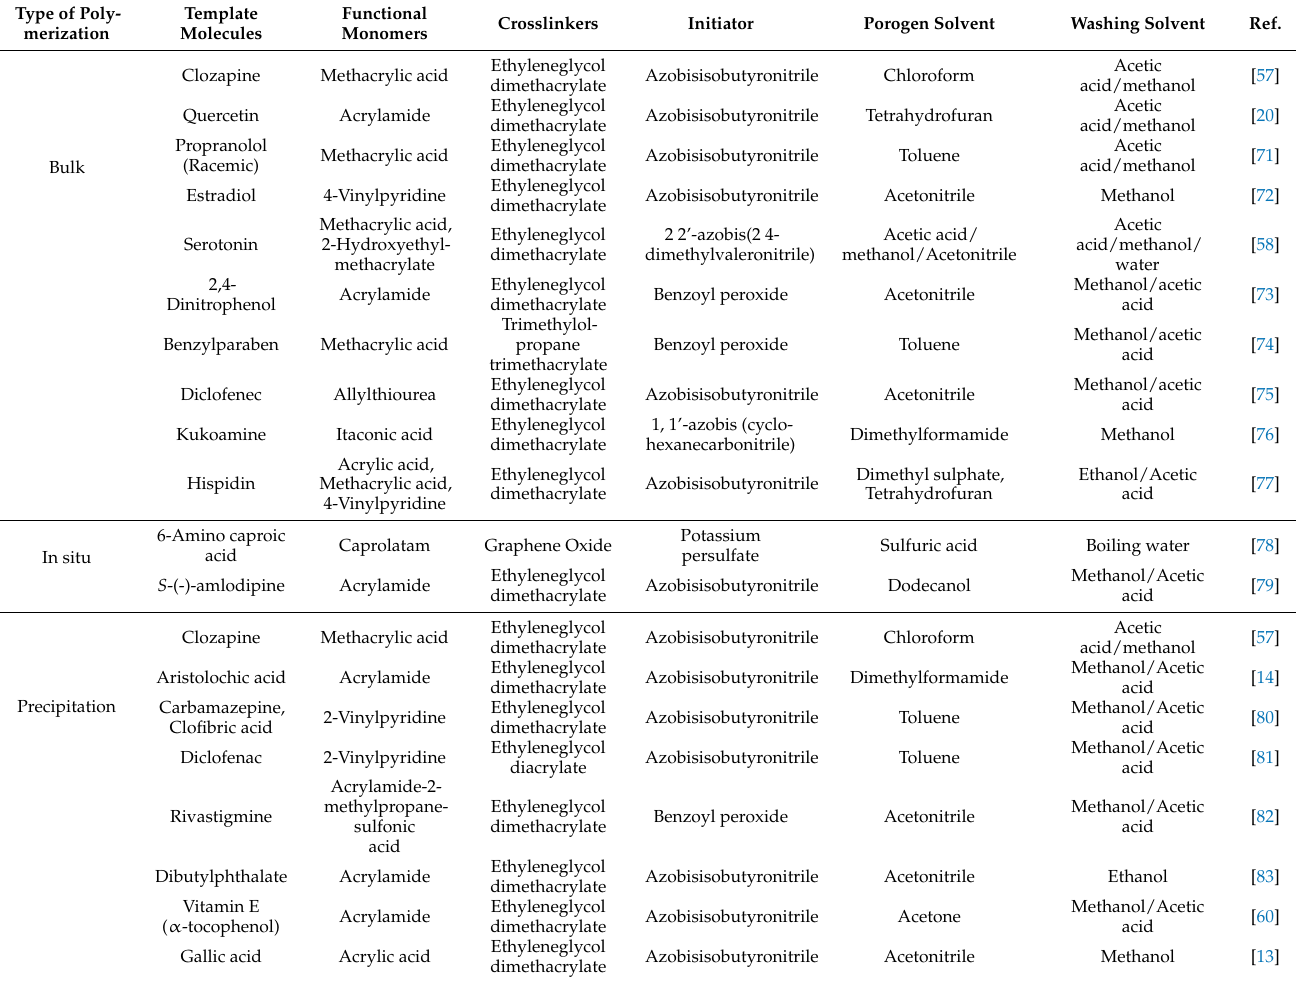
Table 1. Various polymerization techniques for the synthesis of molecular imprinted